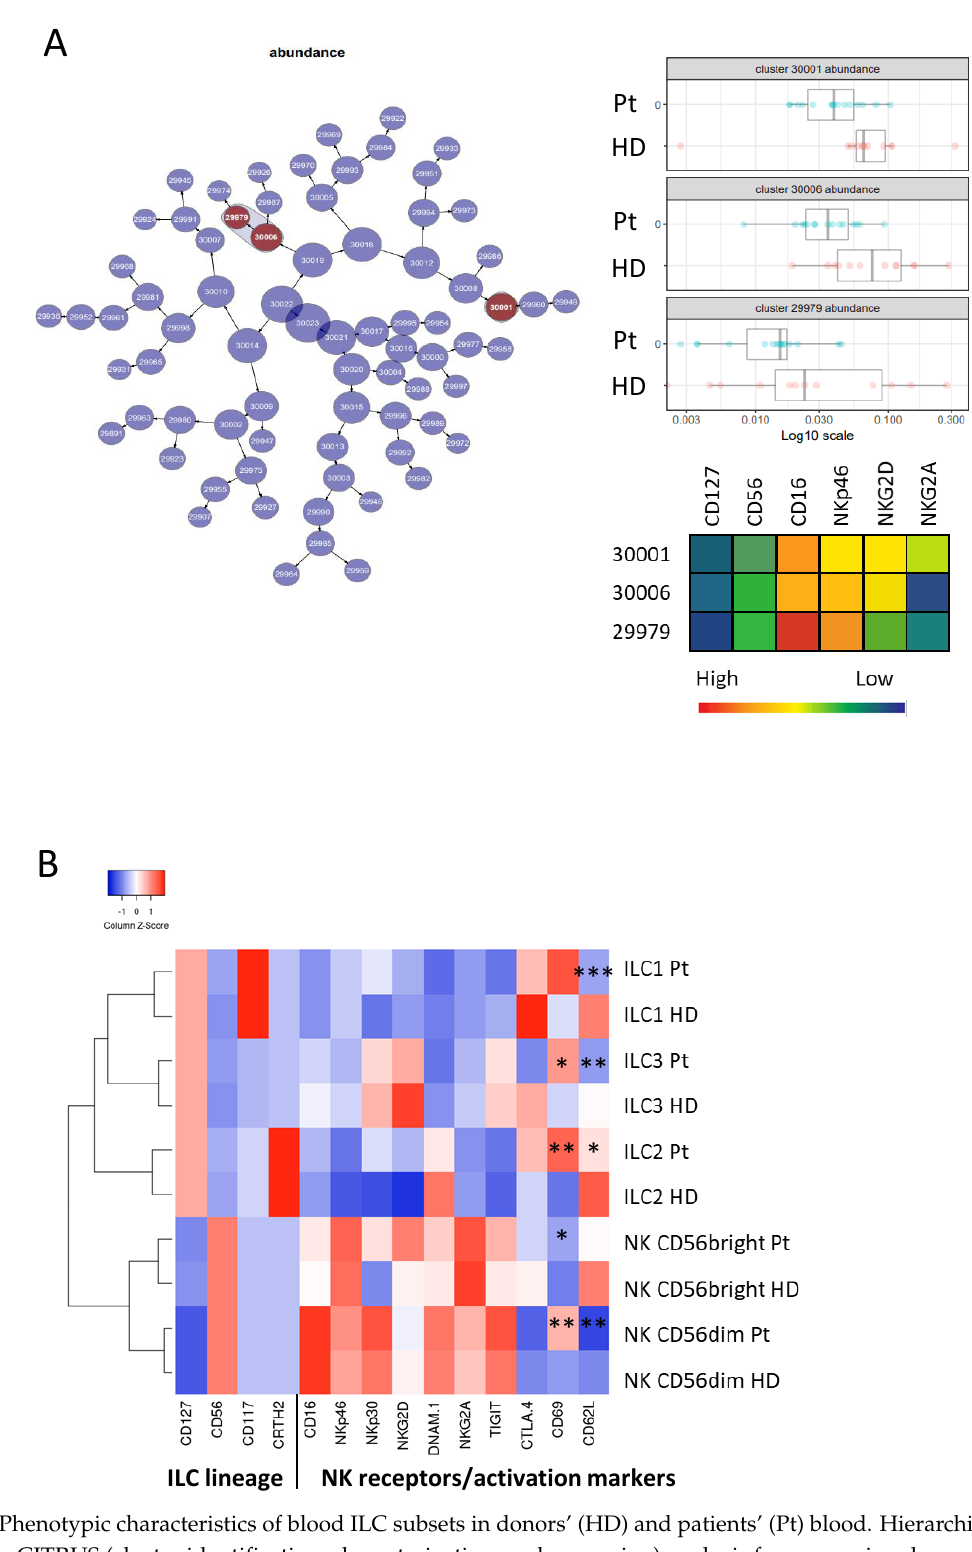
Figure 2. Phenotypic characteristics of blood ILC subsets in donors’ (HD) and patients’ (Pt) blood. Hierarchical clustering map of the CITRUS (cluster identification, characterization, and regression) analysis for comparing donors and patients Figure 2: Phenotypic characteristics of blood ILC subsets in donor (HD) and patients (Pt) blood. before treatment. Clusters whose cell abundances are different between the two conditions are in dark red. Cell abundance in the three clusters is represented on the left side with a heatmap presenting the phenotypes of these clusters ( A ). Heatmap presenting the markers expressed by ILC populations in HD and in Pt. Mann–Whitney test was used to compare HD and Pt (* p < 0.05, ** p < 0.01, *** p <0.005) ( B